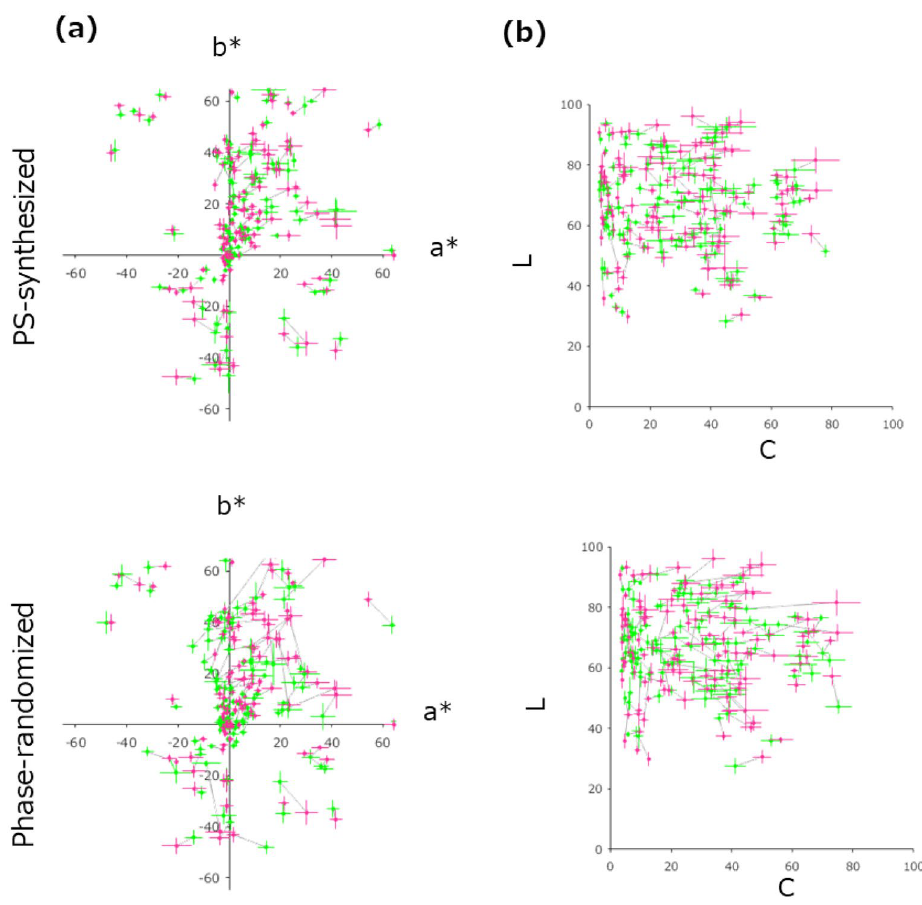
Figure 8. Matched representative colors for PS-synthesized images (upper panels) and phase-randomized images (lower panels). ( a,b ) Matched representative colors for the original and synthetic images. The green circle indicates the mean of the matched representative color of the synthetic images for 10 observers, and the red circle connected to it by a line indicates the mean of matched representative color for the originals: ( a ) shows the result in the a * –b * planes, and ( b ) shows the result in the L-chroma